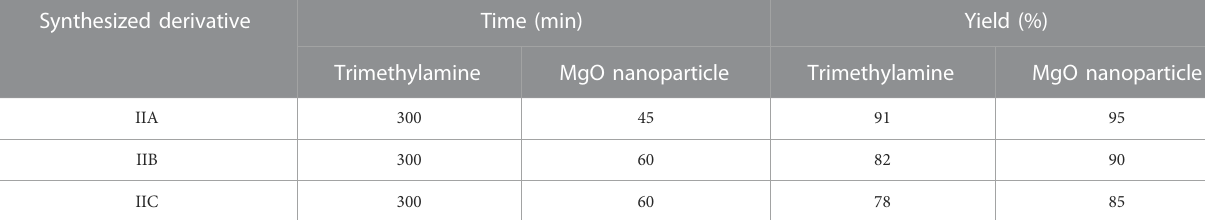
Bold values indicates the optimized reaction condition